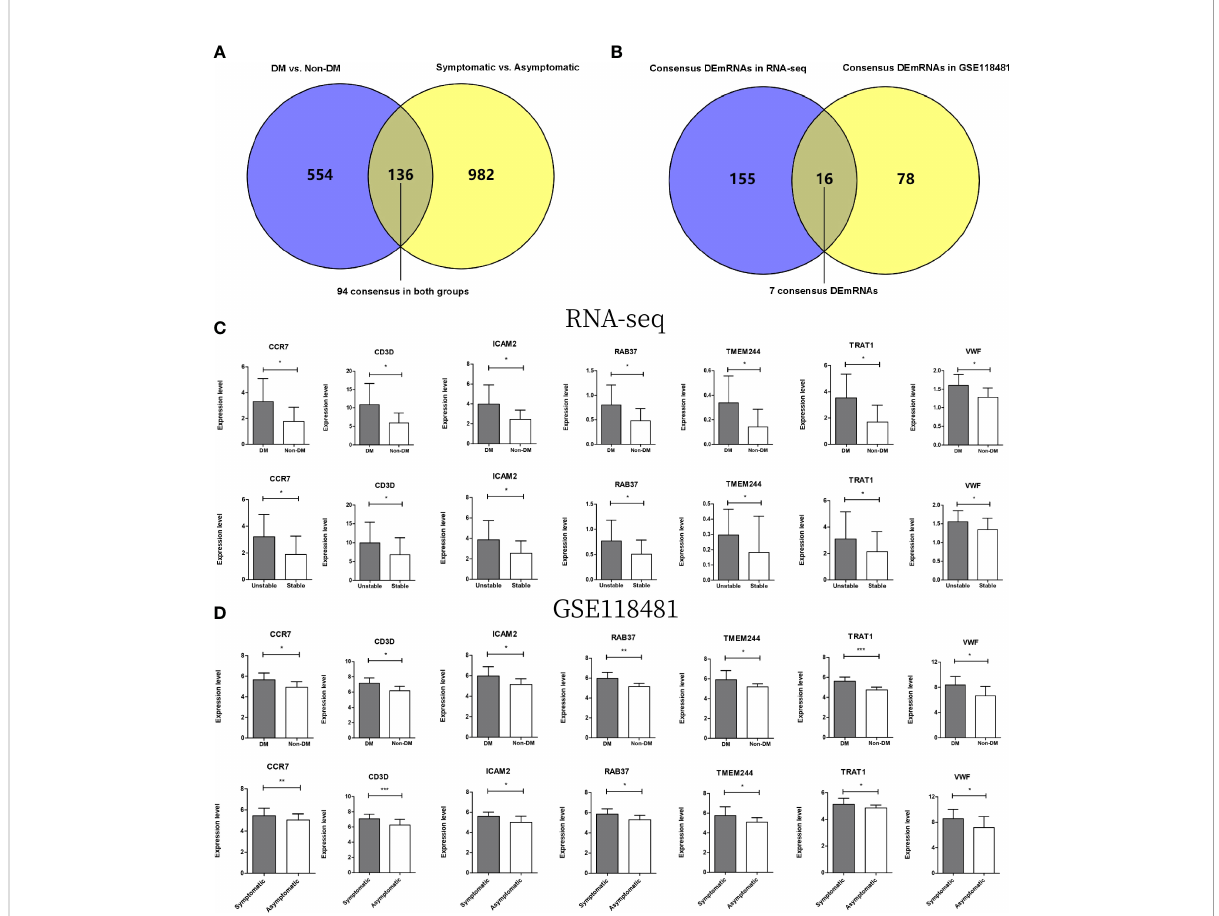
FIGURE 6 (A) Wayne diagram for comparison of signi fi cantly differentially expressed genes in DMs versus non-DM and symptomatic versus asymptomatic groups in GSE118481 datasets. (B) Wayne diagram comparing overlapping genes in DM versus non-DM and stable versus unstable groups with target mRNA in RNA-seq data results. (C) The expression levels of 7 genes were distributed in two comparison groups in the RNA-seq data. (D) The expression levels of 7 genes were distributed in two comparison groups in the GSE118481 dataset. * indicates p <0.05, * * indicates p <0.01, * * * indicates p